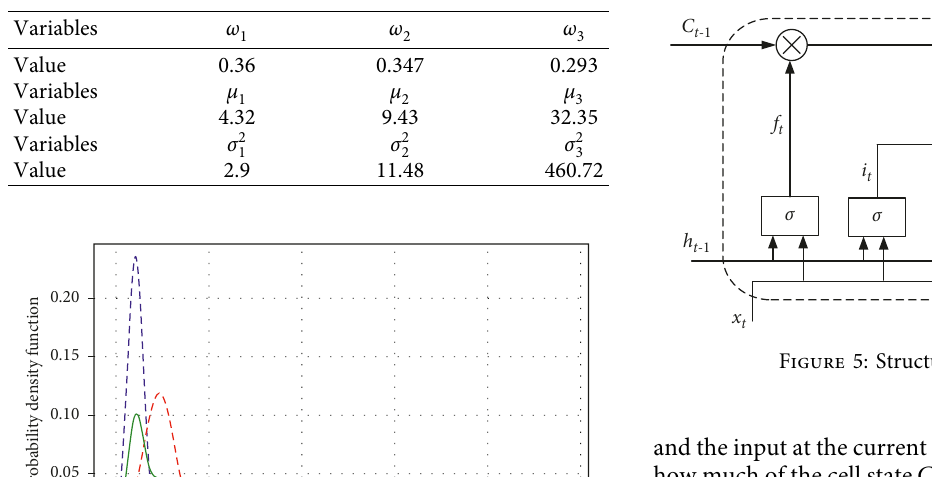
Table 3: The regression results.